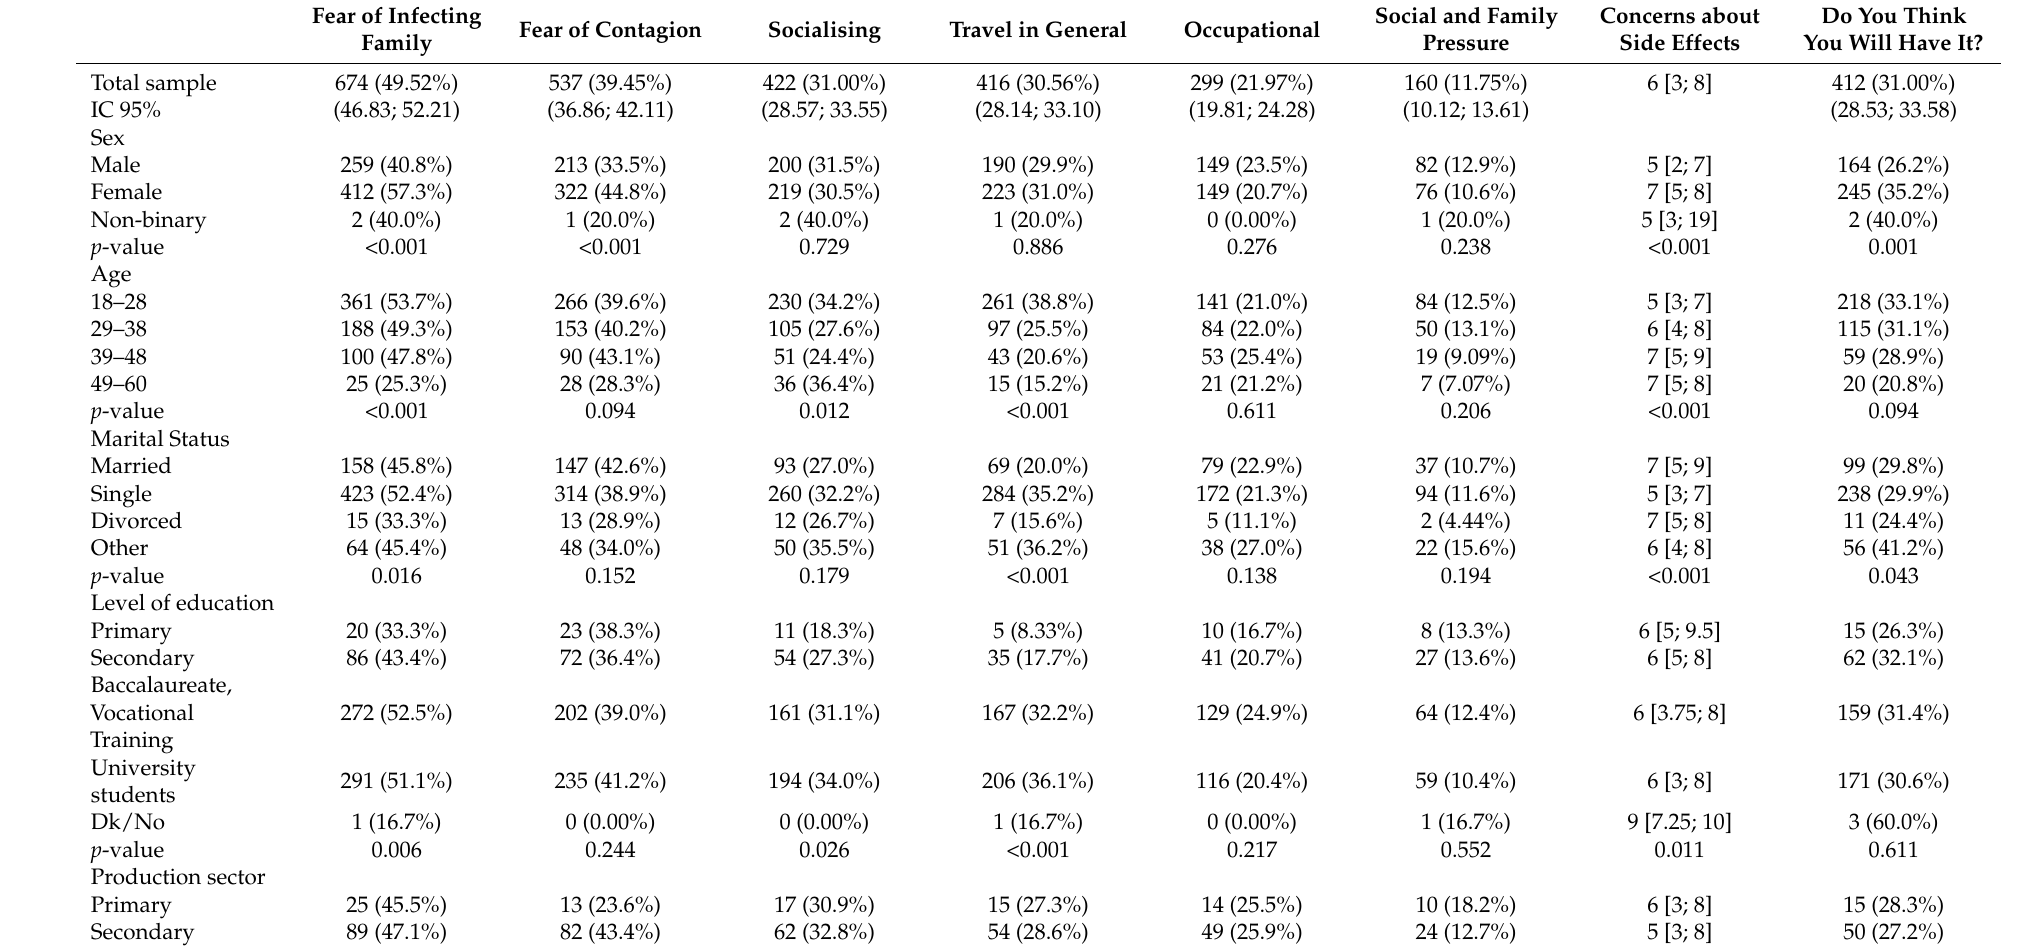
Table 2. Descriptive analysis of the reasons for vaccination and side associations, for the total sample and according to the sociodemographic variables studied. The table shows the absolute frequencies and, in parentheses, the percentages. The test used was the X 2